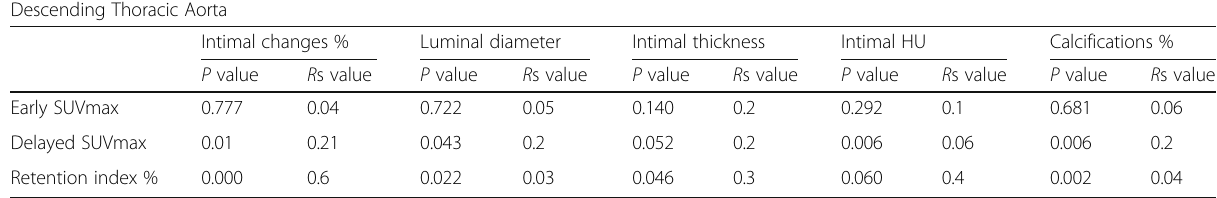
Table 8 Correlation between FDG findings and CT findings in the 50 patients of study population within the descending thoracic aorta Descending Thoracic Aorta